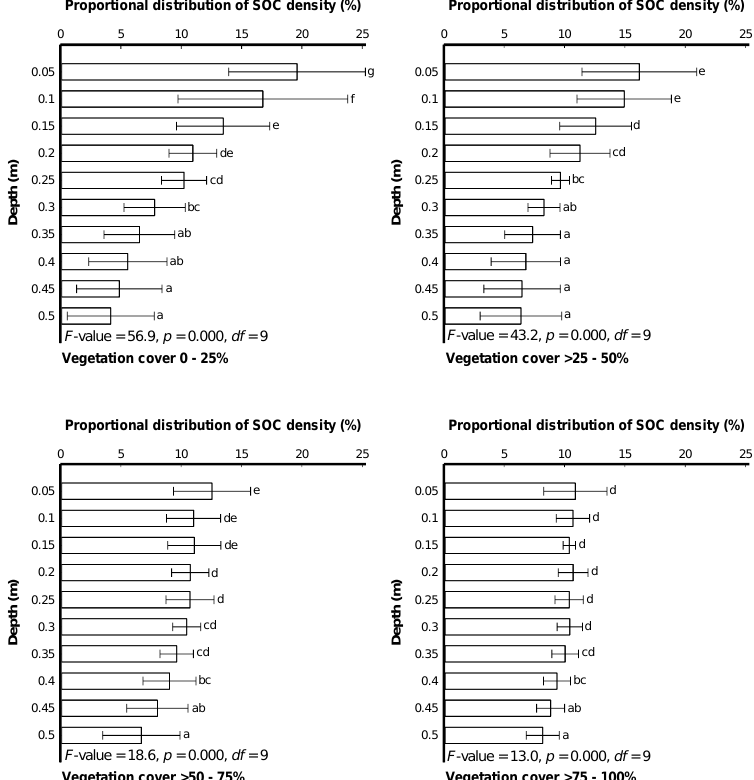
Figure 6. Profiles of volumetric soil organic carbon (SOC) density (kg C/m 3 ) distributions in ten sites of sabkhas with different vegetation covers along the southern Red Sea coast of Saudi Arabia. F -values represent the one-way analysis of variance (ANOVA); df = degrees of freedom; different letters are significantly different at p < 0.05 according to Tukey’s HSD (Honest Significant Difference) test.